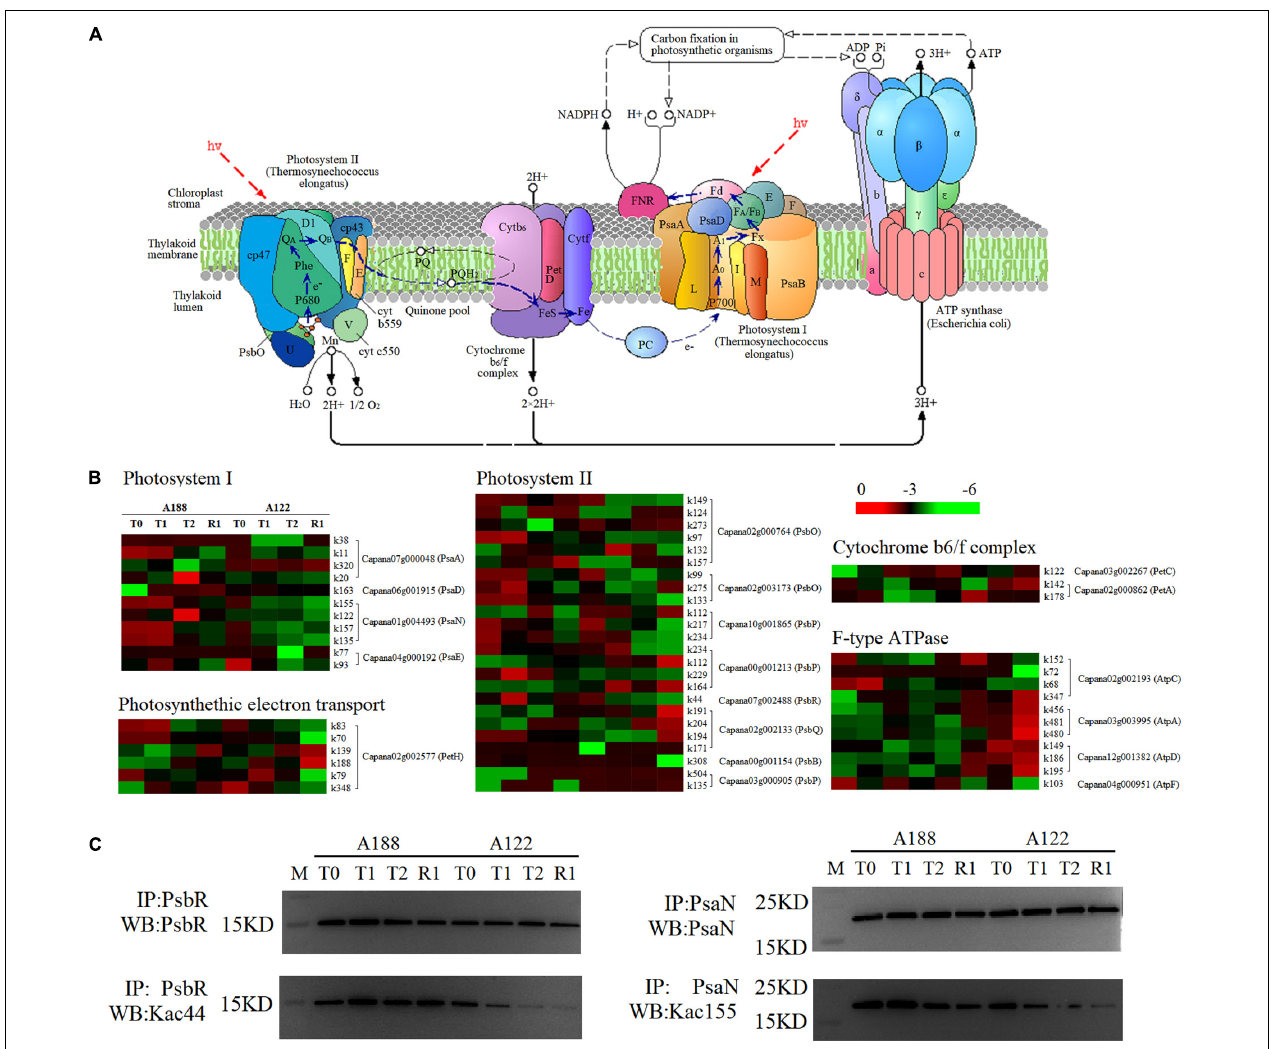
FIGURE 8 | Comparative analysis of acetylated proteins involved in the photosynthesis pathway. (A) Schematic illustration of the photosynthesis pathway. (B) Heat map analysis of acetylated proteins involved in the photosynthesis pathway. (C) Western blotting analysis of photosystem II 10 kDa polypeptide (PsbR) acetylation and photosystem I reaction center subunit N (PsaN). PsaA, photosystem I P700 chlorophyll a apoprotein A1; PsaD, photosystem I reaction center subunit II; PsaN, photosystem I reaction center subunit N; PsaE, Photosystem I reaction center subunit IV A; PsbO, oxygen-evolving enhancer protein 1; PsbP, oxygen-evolving enhancer protein 2; PsbR, photosystem II 10 kDa polypeptide; PsbQ, oxygen-evolving enhancer protein 3-2; PsbB, photosystem II CP47 chlorophyll apoprotein; PetC, cytochrome b6-f complex iron-sulfur subunit; PetA, apocytochrome f; PetH, Ferredoxin–NADP reductase; AtpA, ATP synthase subunit alpha; AtpC, ATP synthase gamma chain; AtpD, ATP synthase delta chain; AtpF, ATP synthase subunit